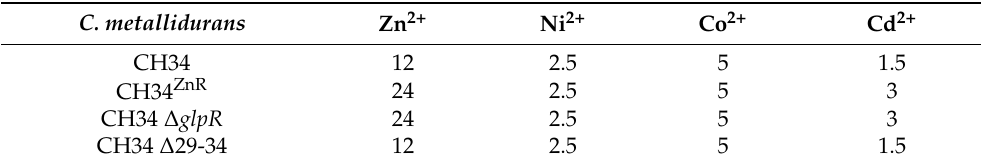
Table 3. Minimal inhibitory concentration (MIC, mM) of different metals determined in liquid MM284 medium for different C. metallidurans strains.